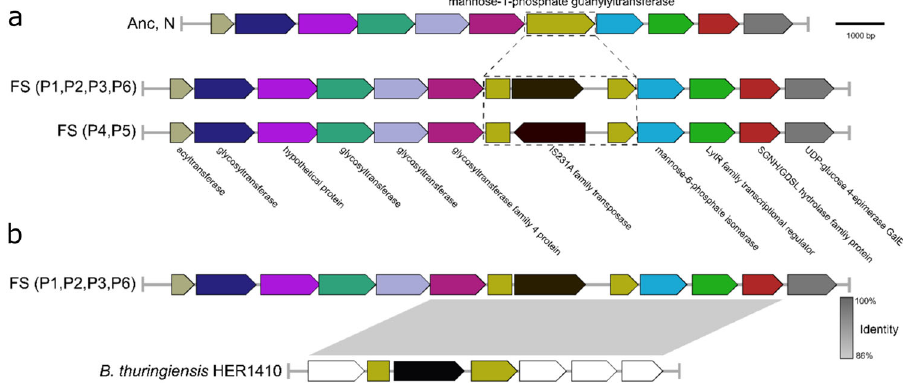
Fig. 5 Comparative genomic characterization reveals insertion sequence plays an important role in the evolutionary adaptation of Bt407. a Genetic properties of the disrupted guanylyltransferase gene. b Identi fi cation of a similar genetic structure of the natural isolate, B. thuringiensis HER1410 with a guanylyltransferase disrupted by a homologous insertion